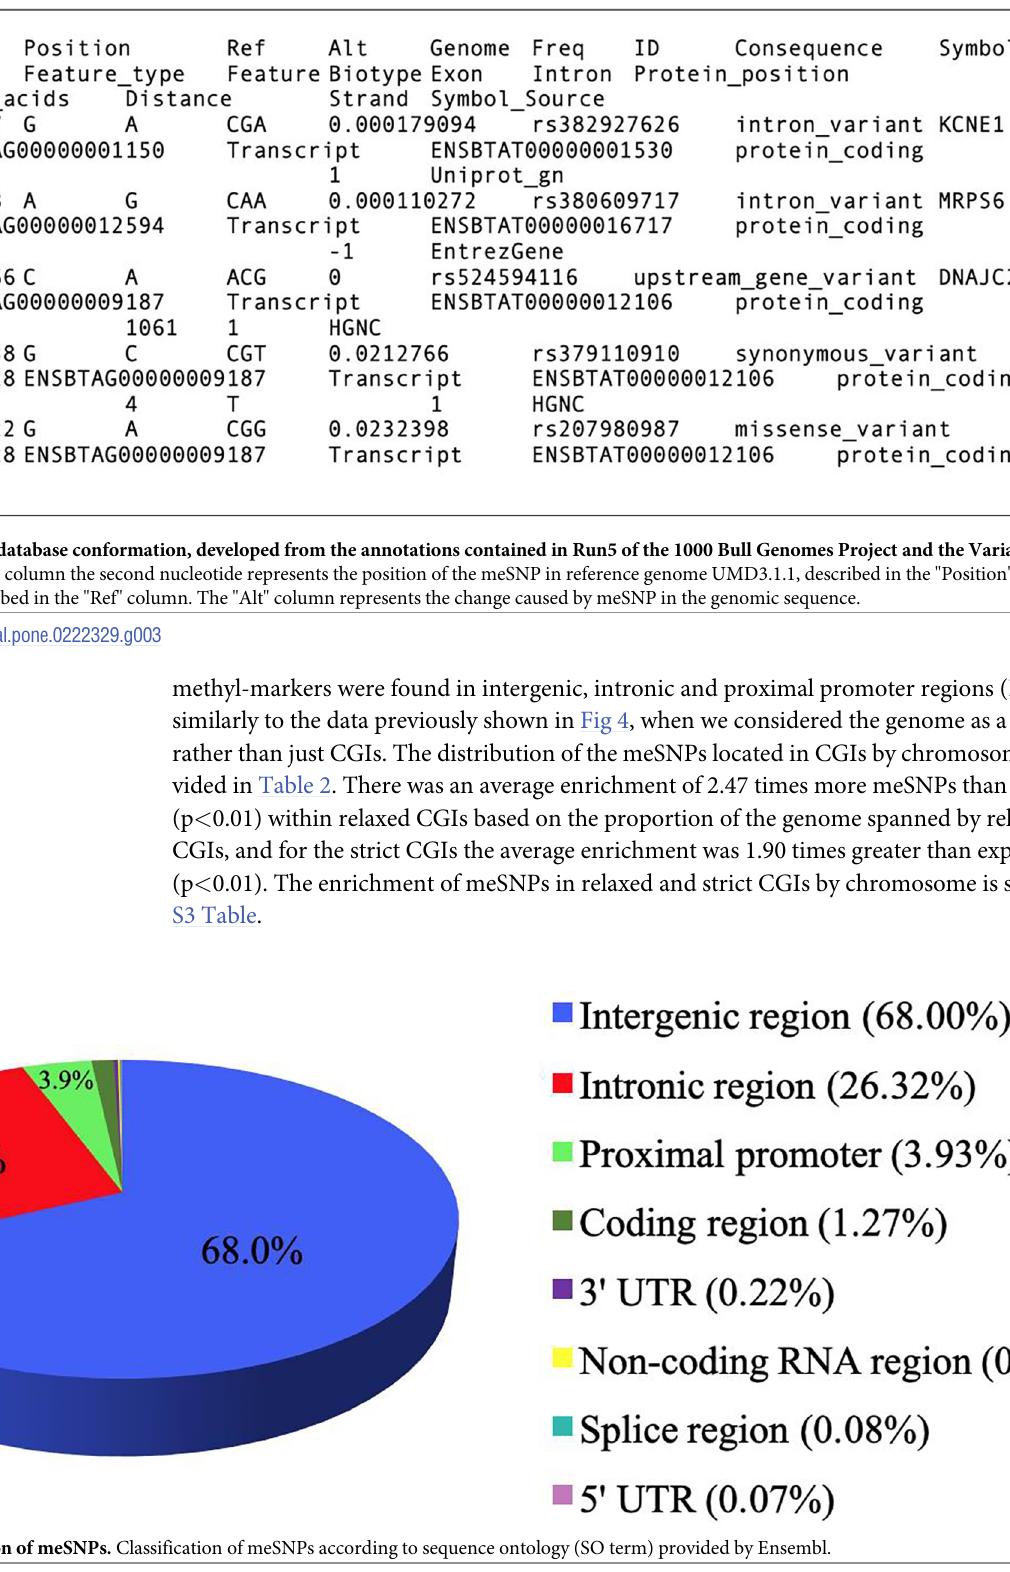
PLOS ONE | https://doi.org/10.1371/journal.pone.0222329 September 12,